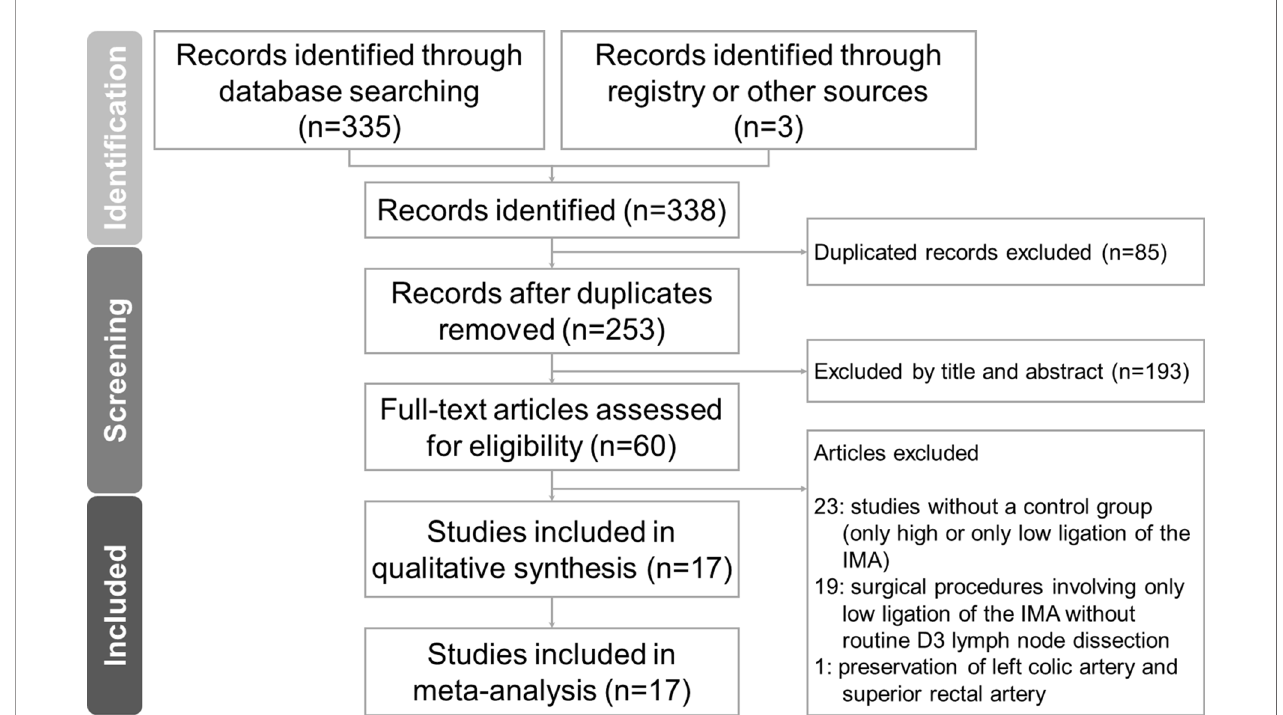
FIGURE 1 | Flow diagram showing the literature search